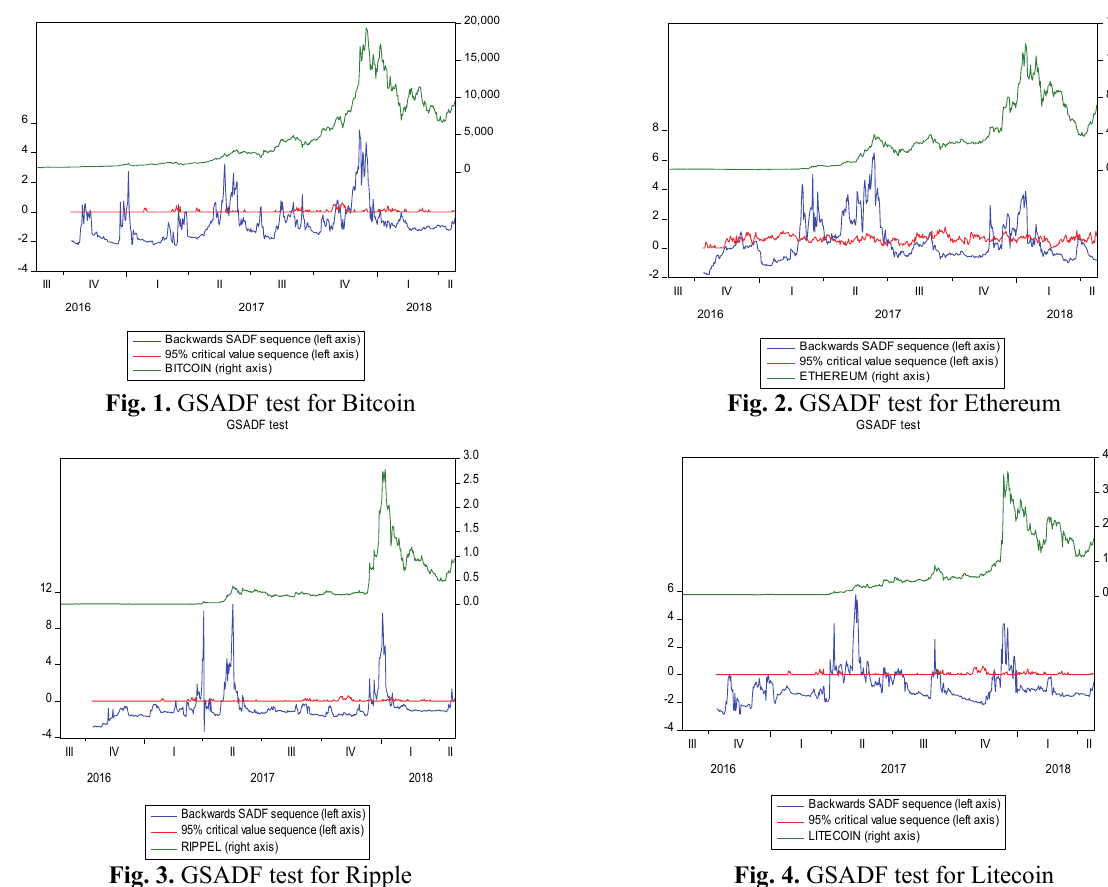
Fig. 1. GSADF test for Bitcoin Fig. 2. GSADF test for Ethereum